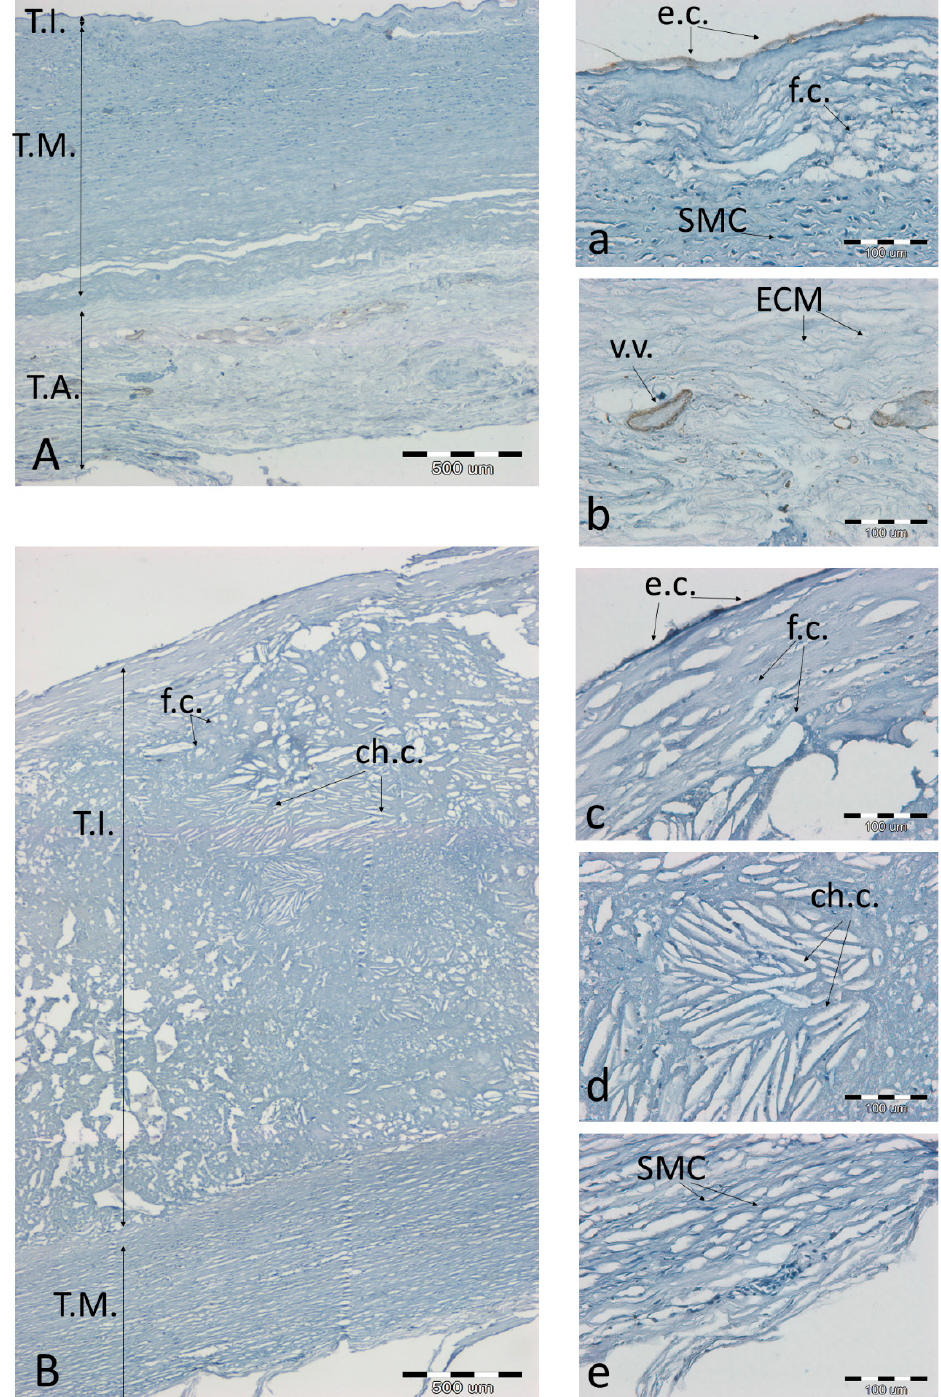
Figure 8. Immunodetection of the NOS ‐ 3 antigen in a representative artery with a low degree of atherosclerosis ( A ,( a , b )) and high degree of atherosclerosis ( B ,( c – e )). A , B —the entire aortic section, 40× magnification, scale bar 500 μ m; ( a – e )— magnification 200×, scale bar 100 μ m. Abbreviations in figures: T.A.—tunica adventitia; T.I.—tunica intima; T.M.—tunica media; ch.c.—cholesterol clefts; v.v.—vasa vasorum; f.c.—foam cells; SMC—smooth muscle cells; e.c.—endothelial cells; a.—adipocytes; ECM—extracellular matrix; MP—macrophages.